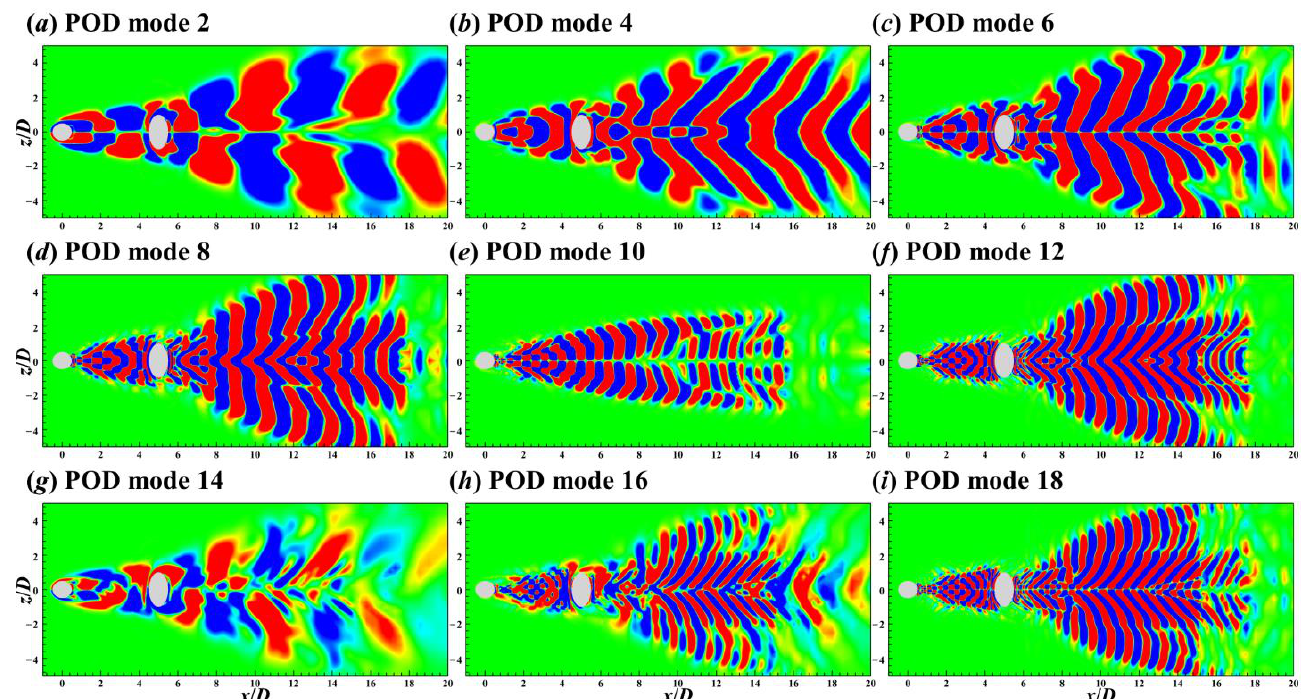
Figure 20. Contours of the 2nd ( a ), 4th ( b ), 6th ( c ), 8th ( d ), 10th ( e ), 12th ( f ), 14th ( g ), 16th ( h ), and 18th ( i ) POD modes on the xz plane for the flow around the two crossing cylinders in 60° arrangement.